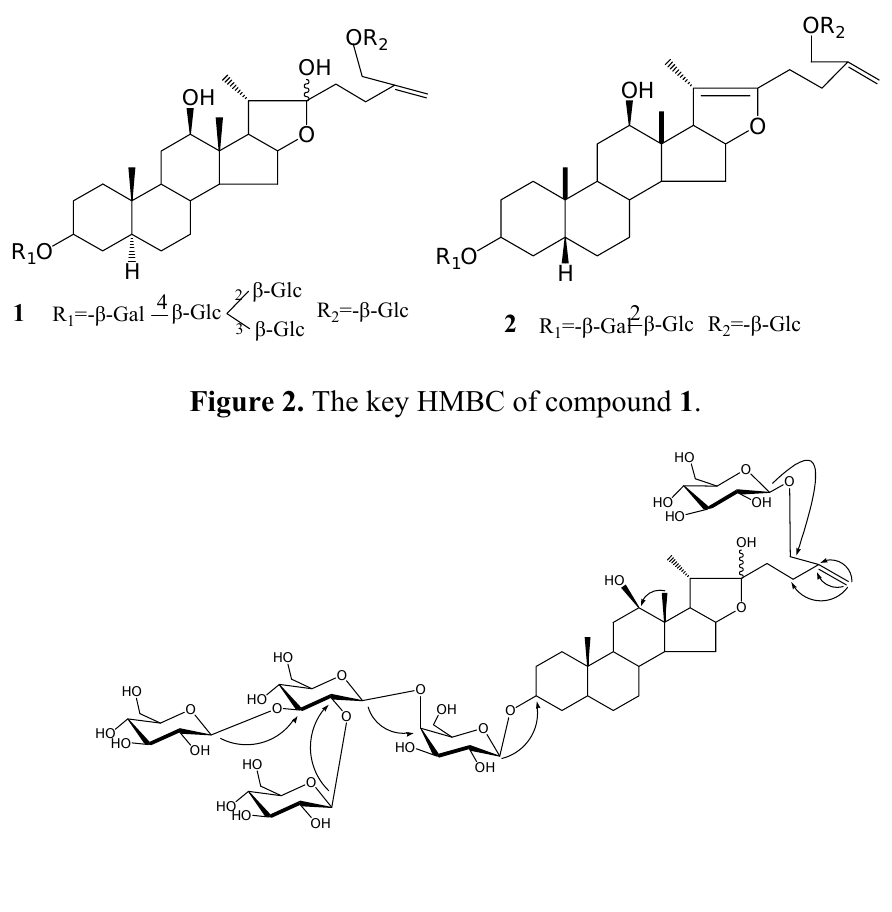
Figure 1. The structures of compounds 1 and 2 .